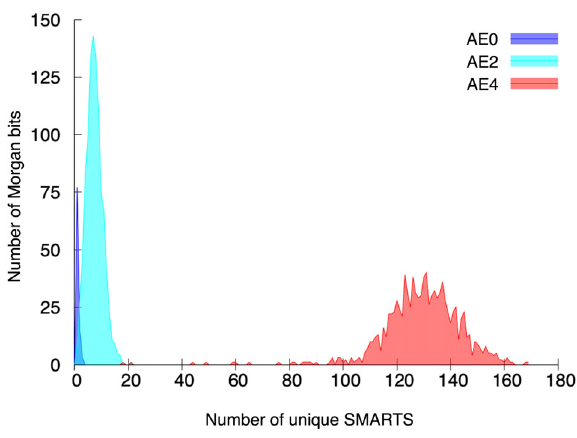
Fig. 2 Optimal radius for Morgan fi ngerprint in a translation task. The number of Morgan bits according to the number of unique SMARTS patterns from AE0 (blue), AE2 (cyan), and AE4